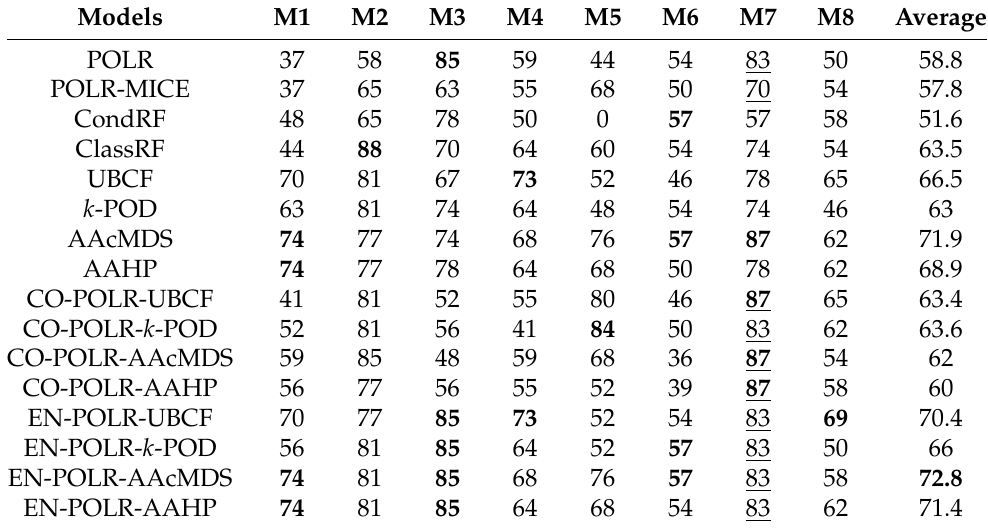
Table 5. Accuracy (percentage) of the classifiers for the different models of shoes and their average for the real dataset. The maximum value in each column appears in bold. Underlined numbers indicate that LDA had to be used instead of